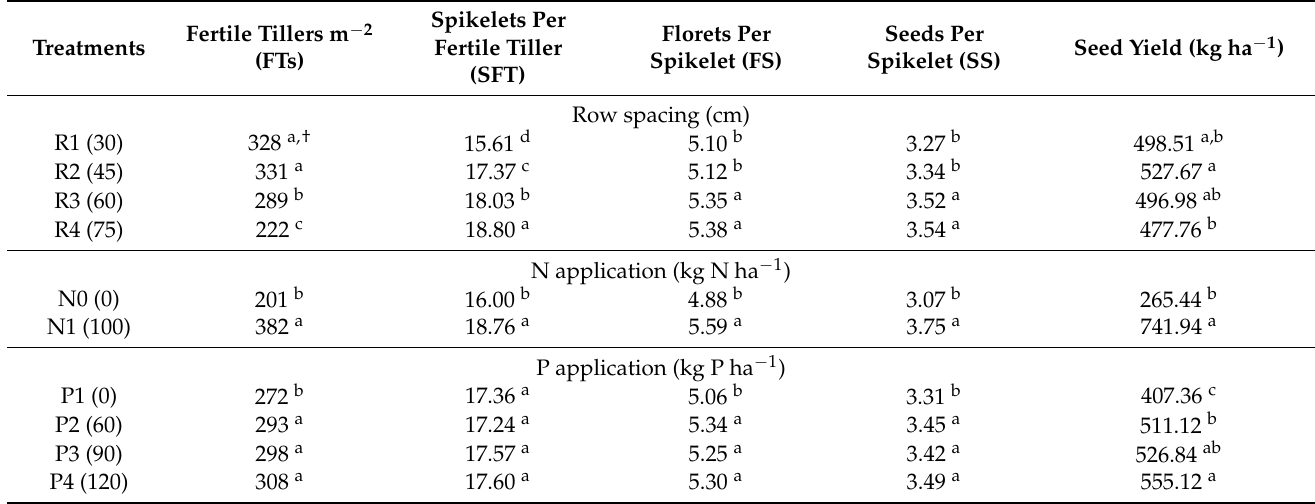
Table 2. Effects of row spacing and N/P application on seed yield and seed yield components in smooth bromegrass.